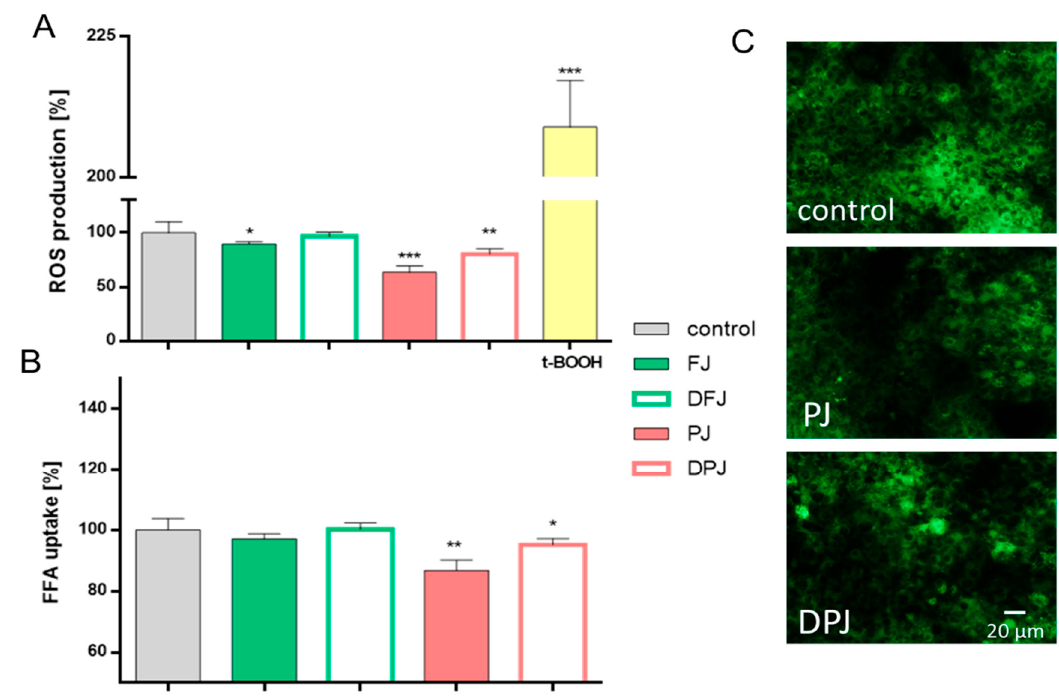
Figure 4. The effect of V. opulus juice samples on intracellular ROS generation ( A ) and the effect on fatty acid analogue TF2-C12 uptake ( B ) in L6 cells after incubation with fresh juice (FJ), digested fresh juice (DFJ), purified juice (PJ), and digested purified juice (DPJ) after 24 h incubation; for positive control for ROS generation, 500 µM tert -BOOH was used; values are means ± standard deviations from at least five independent experiments, n ≥ 9; statistical significance was calculated versus control cells (untreated), * p ≤ 0.05, ** p ≤ 0.01, *** p ≤ 0.001. Cellular uptake of TF2-C12 analogue visualized under a fluorescent microscope (200× magnification) ( C ).